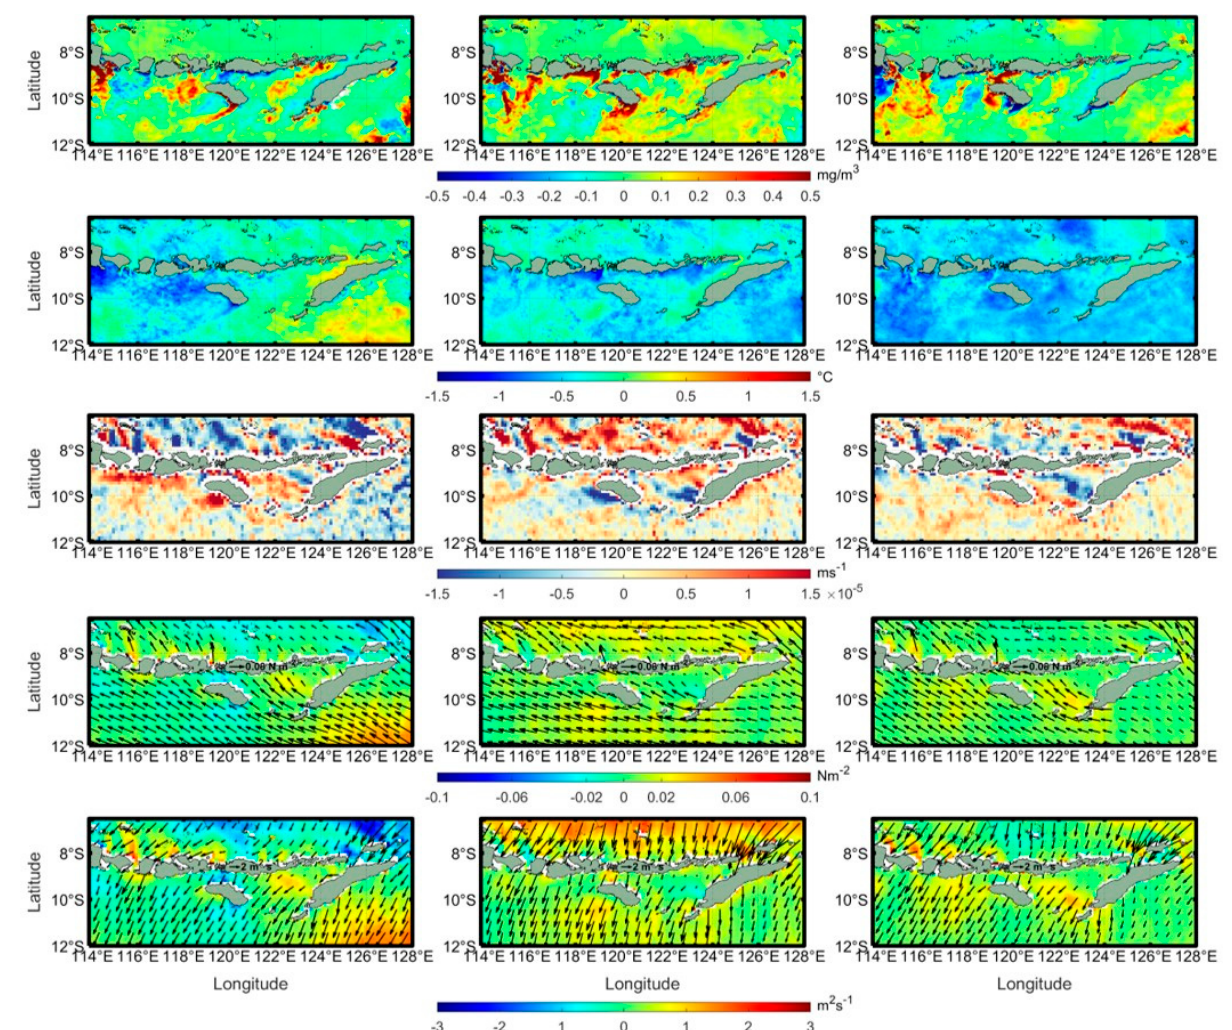
Figure 14. The anomalies of chlorophyll-a, sea surface temperature (SST), Ekman Pumping Velocity (EPV), wind stress, and Ekman Mass Transport (EMT) during the 2007 La Nina (June–August from left to right), respectively (from top to bottom).